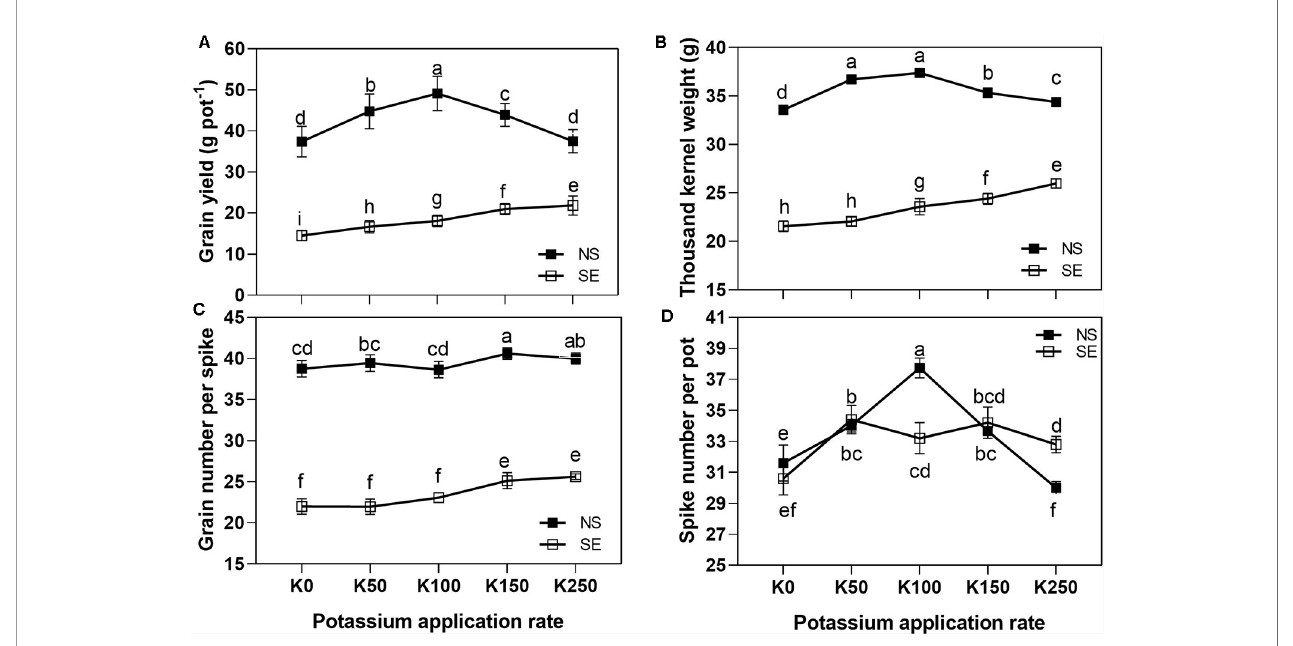
FIGURE 1 | Wheat yield and its components in different treatments. The error bars stand for standard deviations of the means of fi ve independent biological replicates. For each trait, different letters represent signi fi cant difference from each other according to two-way ANOVA after testing with least signi fi cant difference (LSD) multiple comparison (P < 0.05) . NS, no shading treatment; SE: shading from the 1st day to the 10th day after anthesis (shading at early fi lling stage for 10 days, SE); Five potassium rate: 0 (K0), 50 (K50), 100 (K100), 150 (K150), and 250 (K250) mg K 2 O kg -1 soil in the form of